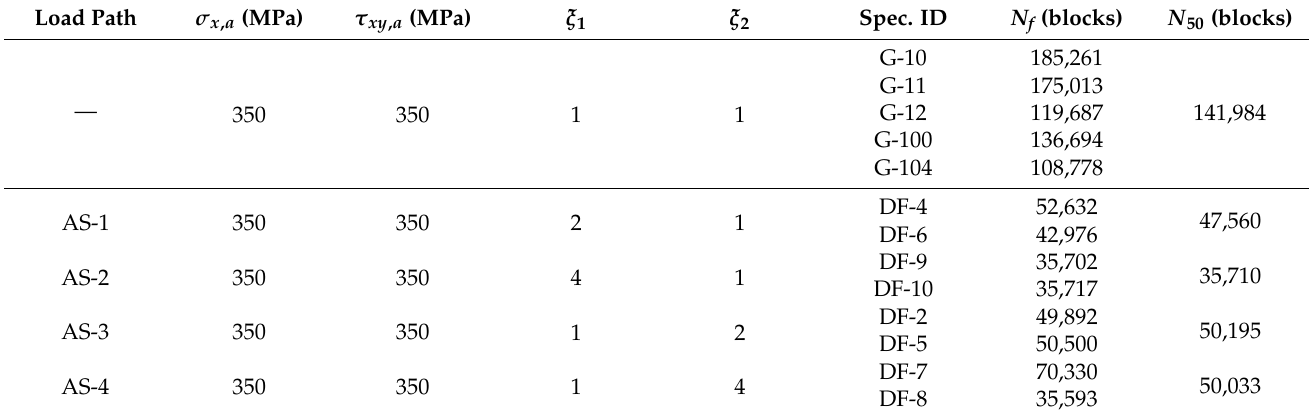
Table 3. Test results under different frequency